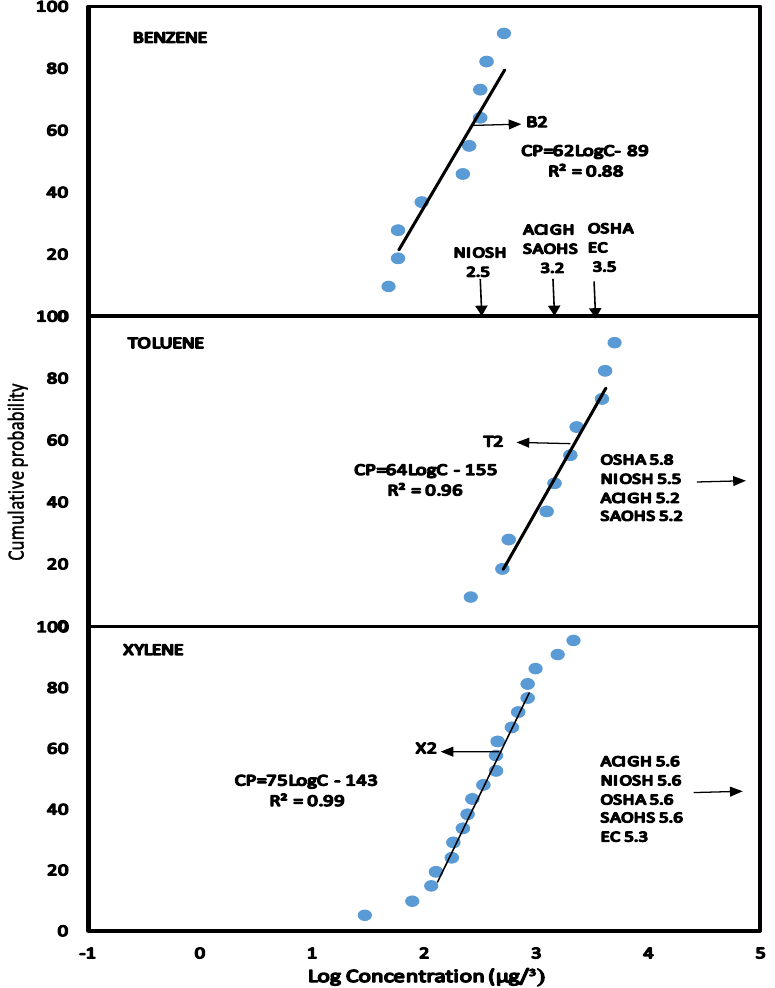
Figure 2. Scenario 2, CPD plots for exposure to mechanics repairing and maintaining fuel pumps to concentrations of benzene, toluene and xylene in air as measured by personal air sampling